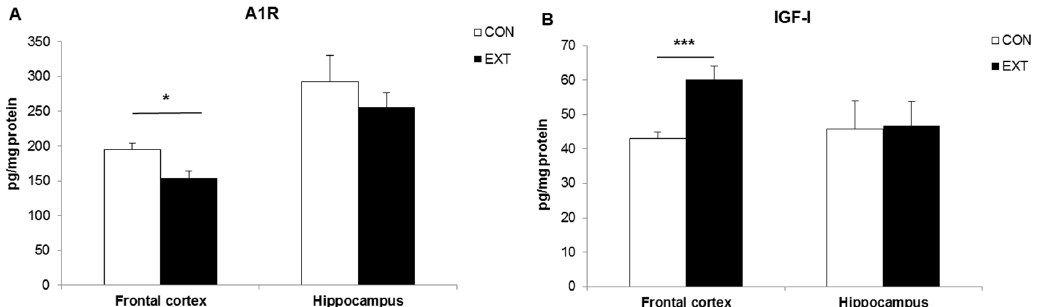
Figure 1. Adenosine A 1 receptor (A1R) ( A ) and IGF-I ( B ) protein concentrations in the frontal cortex and hippocampus of rats after 14 days of habitual (CON) and extended (EXT) light–dark conditions (respectively 12:12 h and 16:8 h). n = 12 per group. Significant difference between CON and EXT: * p < 0.05; *** p < 0.001.